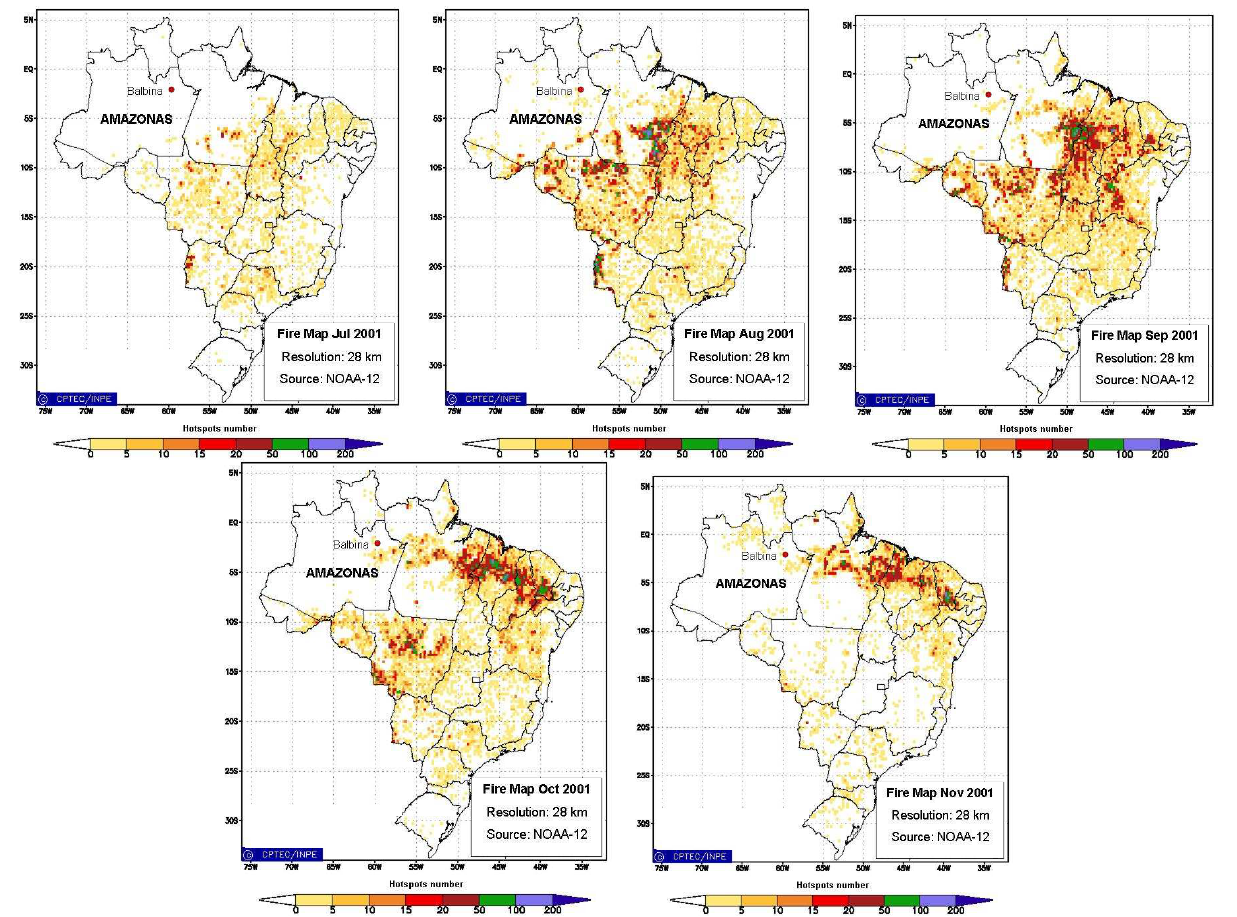
Fig. 5. Spatial distribution of fire hotspots in Brazil for Jul–Nov in 2001. The Amazonas state had not an important contribution of biomass- burning emissions, in spite of an increase (mainly southeast from Balbina) of hotspots after August. Source: CPTEC/INPE (at http://www.